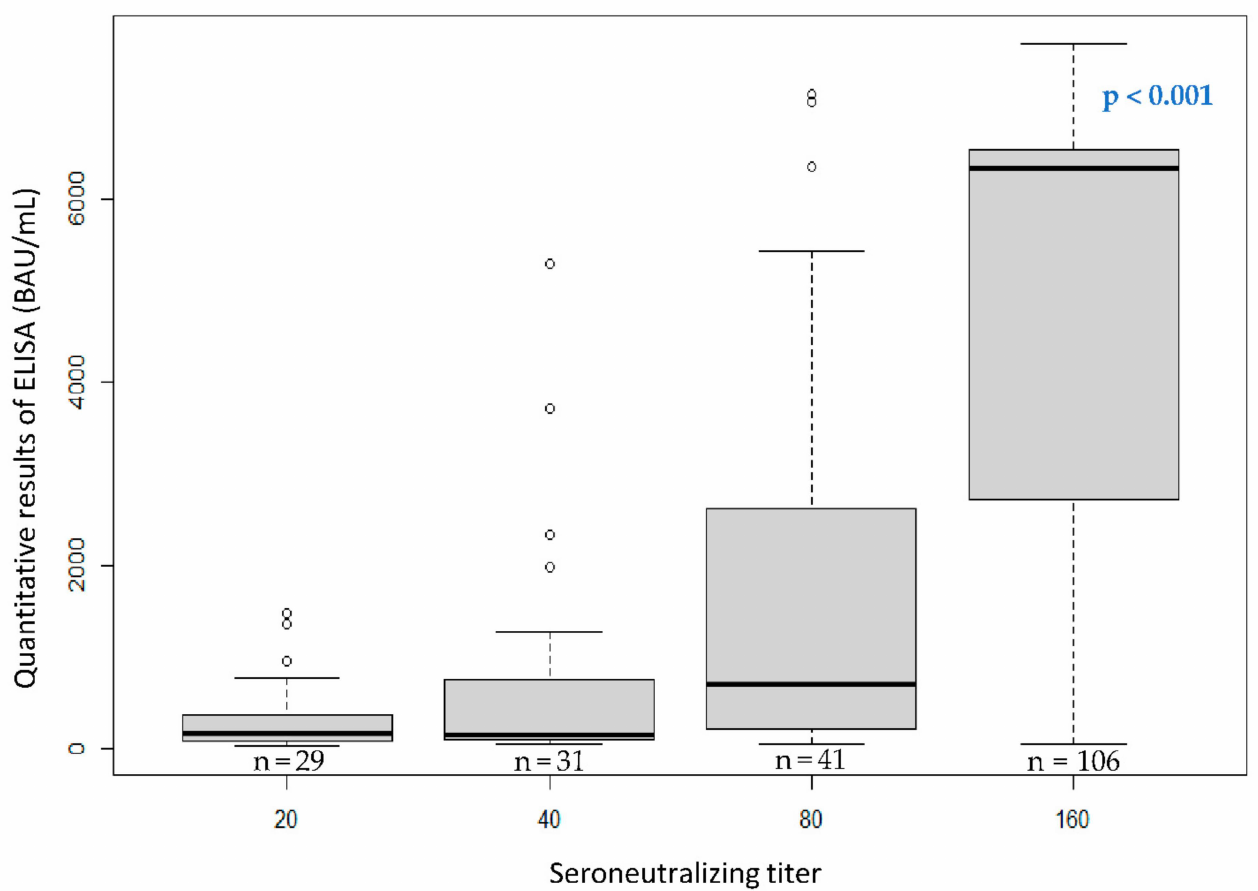
Figure 5. Boxplot of the quantitative ELISA-S results according to neutralizing antibody titers among the